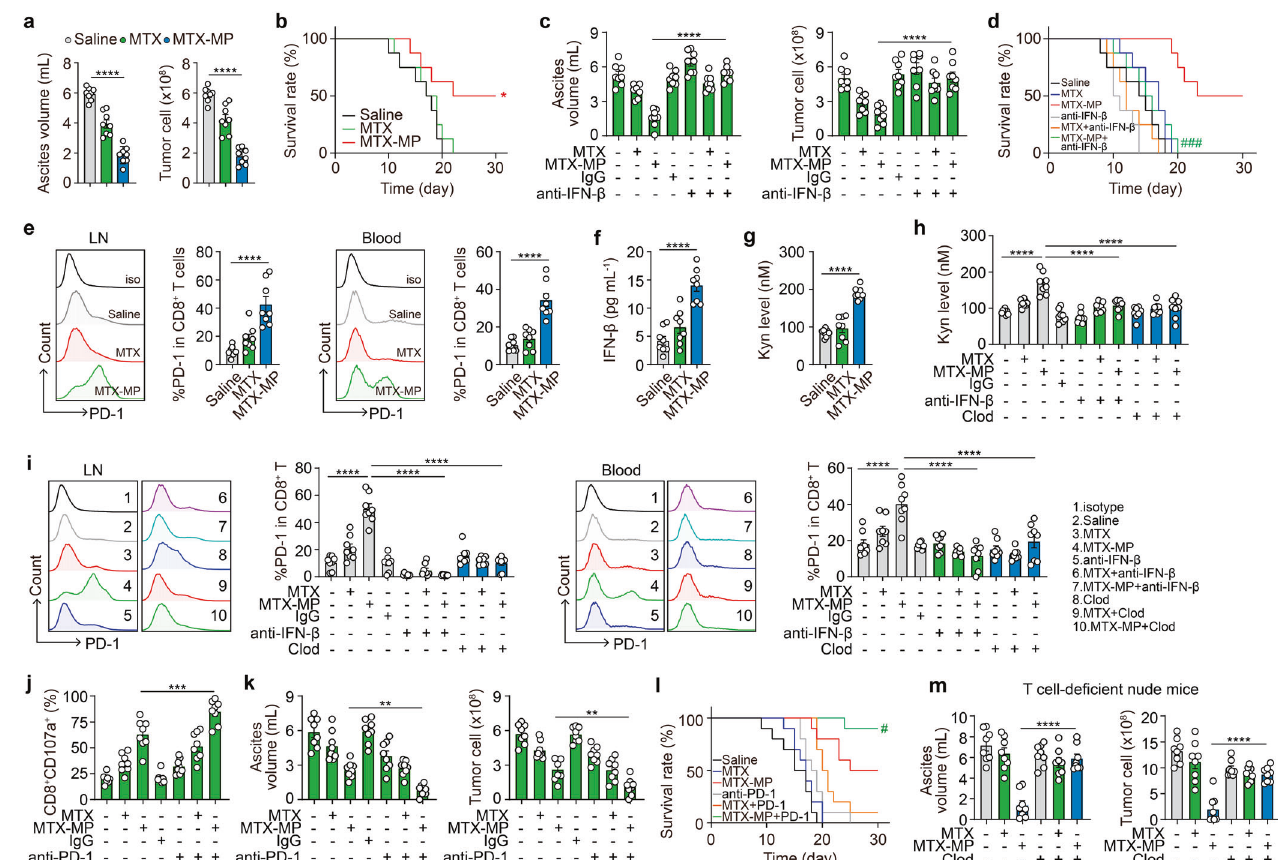
Fig. 7 Drug-MPs synergize PD-1 blockade to treat malignant ascites. a , b 1 × 10 5 H22 tumor cells were intraperitoneally (i.p.) injected into BALB/c mice. The next day, saline, MTX (2 µg) or 2 × 10 6 MTX-MPs (containing ~2 µg MTX) were i.p. injected into the mice once every day for 15 days. On day 15, mice were sacri fi ced. The ascites volume and number of CD45 - tumor cells were determined ( a ). The long-term survival of tumor-bearing mice was assessed ( n = 8) ( b ). c, d the same as ( a , b ), except that some mice were i.p. injected with IgG or anti-IFN- β neutralizing antibodies (100 µg/mouse) once per 2 days for 15 days ( n = 8). #, MTX-MPs vs MTX-MPs + anti-IFN- β group. e – g the same as ( a ), except that CD8 + PD-1 + cells of mesenteric lymph node (LN) and peripheral blood were analyzed by fl ow cytometry ( e ), IFN- β ( f ) and Kyn level ( g ) in ascites were analyzed by ELISA. h , i the same as ( c ), except that some mice were i.p. injected with clodronate liposomes and Kyn level ( h ) in ascites was analyzed by ELISA, CD8 + PD-1 + cells of mesenteric lymph node (LN) and peripheral blood were analyzed by fl ow cytometry ( i ). j – l the same treatment as (a), except that some mice were i.p. injected with IgG or anti- PD-1 neutralizing antibodies (250 µg/mouse) once per 2 days for 15 days. CD8 + CD107a + cells were analyzed by fl ow cytometry (n = 8) ( j ), ascites volume and number of CD45 - tumor cells were determined ( n = 8) ( k ) and the long-time survival of mice was assessed ( n = 10). #, MTX-MPs vs MTX-MPs + anti-PD-1 group ( l ). m 1 × 10 5 H22 tumor cells were i.p. injected into nude mice. The next day, saline, MTX or MTX-MPs were i.p. injected into the mice once every day for 15 days. At the same time, some mice were i.p. injected with clodronate liposomes for 15 days. On day 15, mice were sacri fi ced. The ascites volume and number of CD45 - tumor cells were determined. Unless otherwise speci fi ed, n = 3 biologically independent experiments were performed. Data are presented as mean ± SEM. P values were calculated using one-way ANOVA ( a , c , e – k and m ) and a two-sided log-rank (Mantel-Cox) test ( b , d and l ). * P < 0.05, ** P < 0.01, *** P < 0.001, **** P < 0.0001, # P < 0.05, ### P <